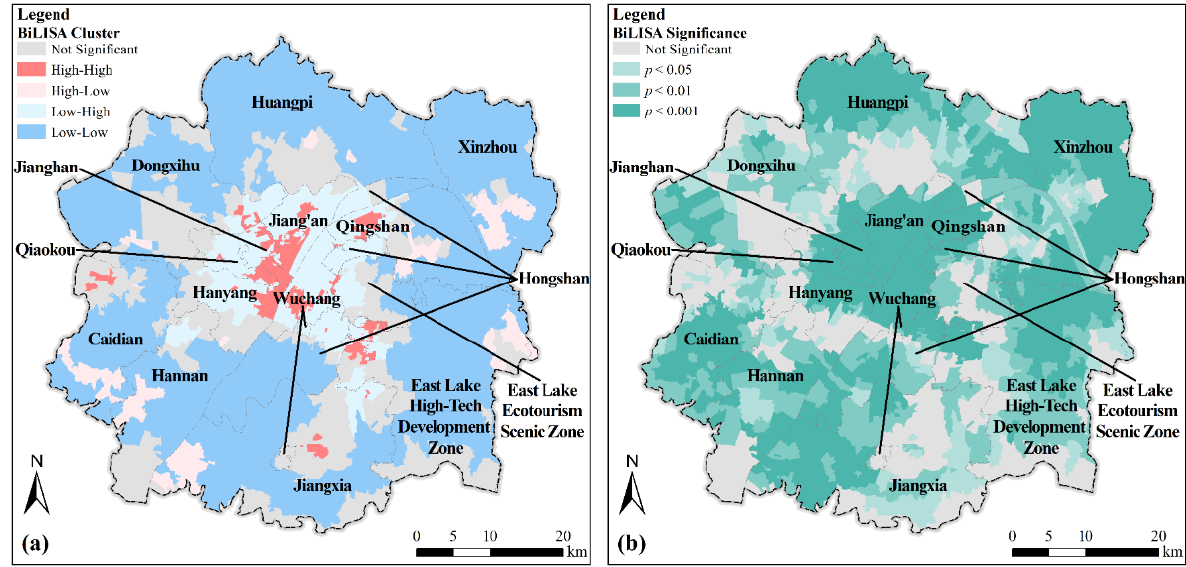
Figure 9. Local spatial correlations of education accessibility and quality. ( a ) Bivariate local Moran’s I cluster map; ( b ) Bivariate local Moran’s I significance map.